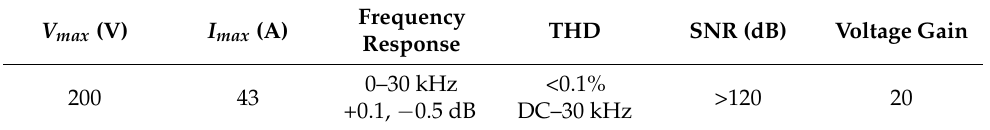
Table 2. Power amplifier specifications.